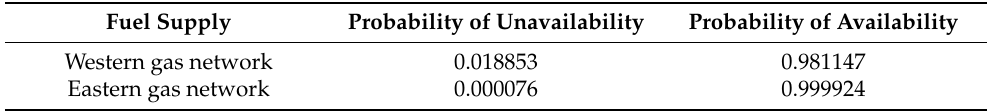
Table 3. Fuel supply with its equivalent